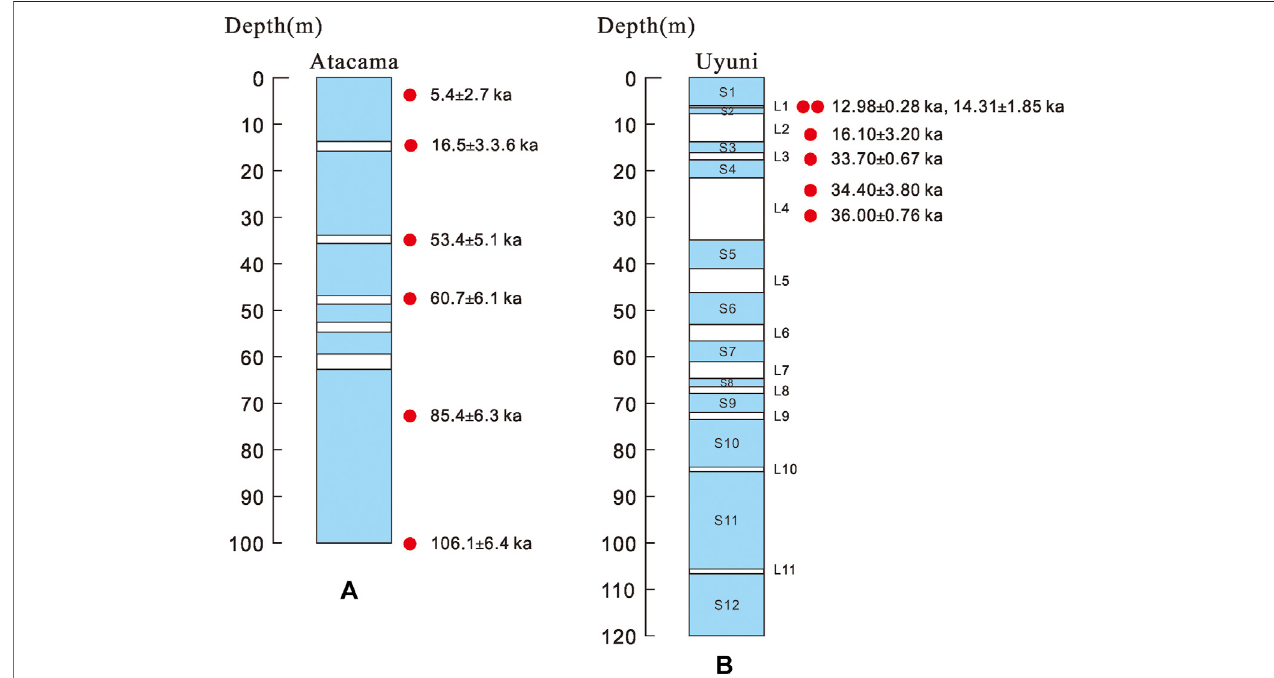
FIGURE 8 | Stratigraphy, sample site, and dating results for salt lakes in South America: (A) core in the Salar de Atacama, the dating results being analyzed by the radiocarbon dating method Bobst et al. (2001); and (B) core in the Salar de Uyuni, for which the U-series disequilibrium dating method is used. The blue squares represent the salt layers and the white squares represent the lacustrine layers Fornari et al. (2001).